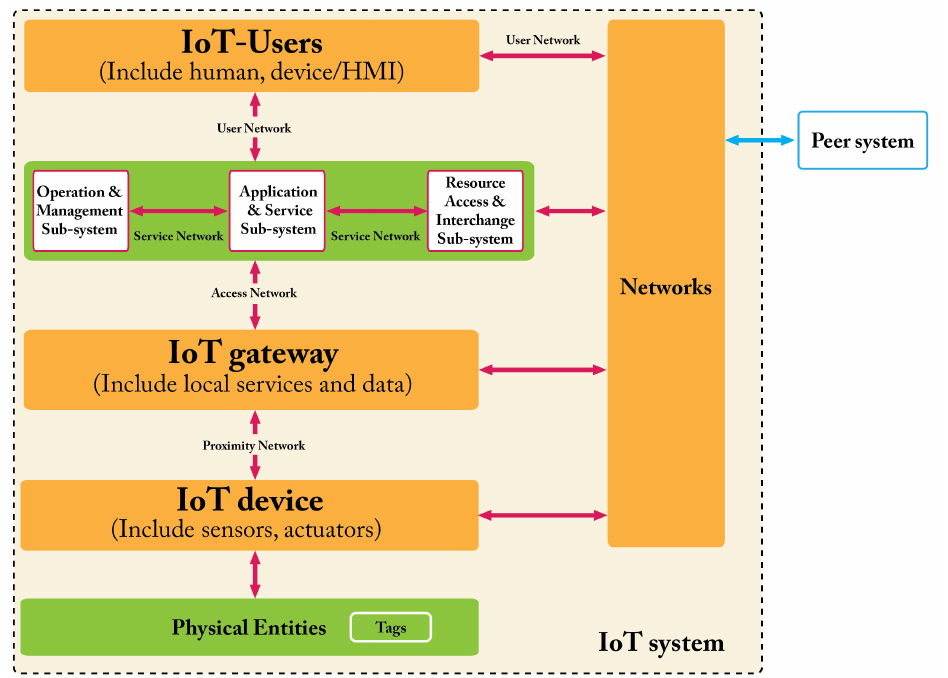
Figure 6. The entity-based IoT